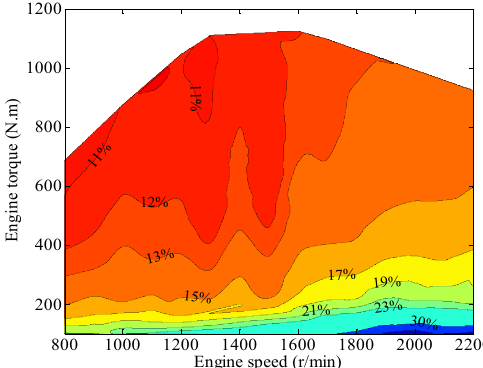
Figure 14. The distribution map of the POIR under the CNG engine test region.